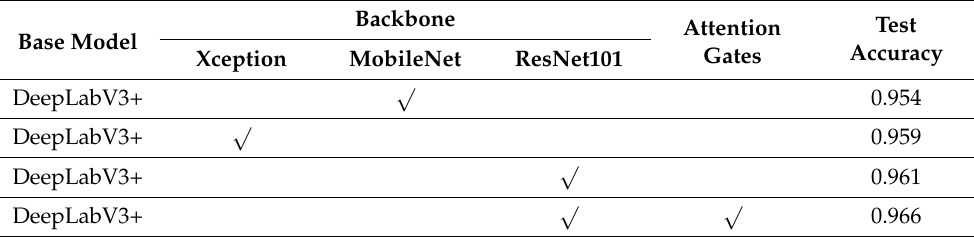
Table 3. Comparison of DeepLabv3 + model